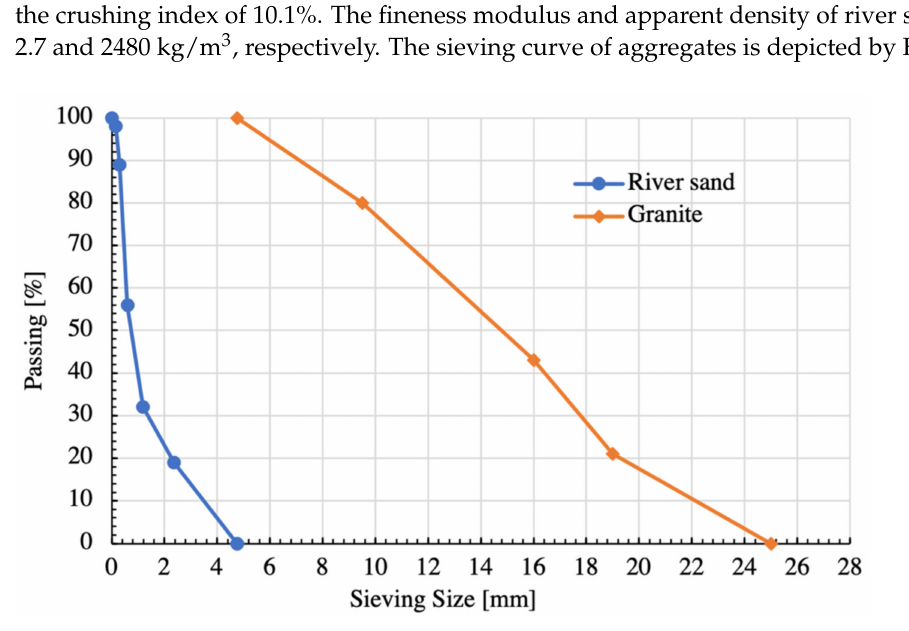
Figure 1. Sieving curve of